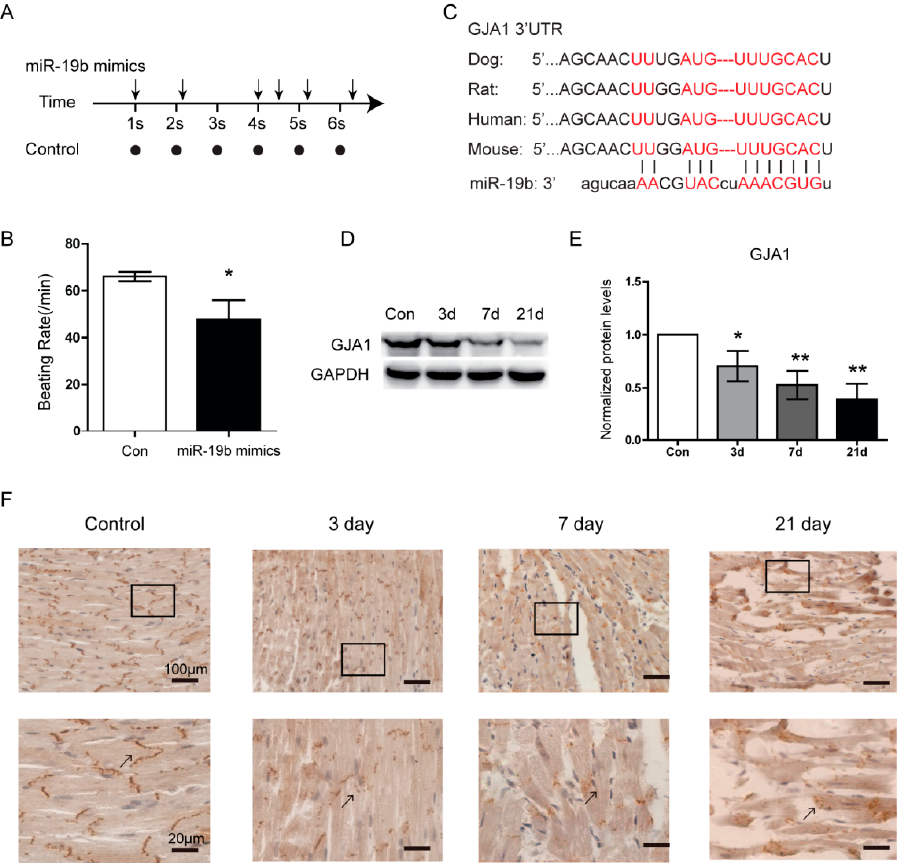
Figure 2. The expression of GJA1 was reduced in the heart of mice bearing VMC. ( A ) The representative beating pattern of cardiomyocytes treated with miR-19b mimics. Each arrow represented one beating of cardiomyocytes and horizontal axis showed the time intervals between two close beats. And the plots represented the control; ( B ) The beating rate of hiPSCs-CMs was shown in different groups; ( C ) The computational alignment of a potential conserved target site of miR-19b in different species. Red sequences represent the complementary bases between miR-19b and GJA1 3’-UTR in species including Homo sapiens , rat, dog and mouse; ( D , E ) GJA1 protein levels were detected at the indicated time of VMC mice model by western blot and the intensity quantification analysis. GJA1 was reduced as the development of VMC; ( F ) IHC analysis showed that GJA1 protein was reduced in VMC mice compared to normal mice. Black arrows showed the gap junctions became uncontinuous and represented that GJA1 was less expressed. Bottom images were magnifications of upper ones. Scare bars for upper panes are 100 μ m and for bottom ones are 20 μ m. n = 3 per group, * p < 0.05, ** p < 0.01 vs . control.